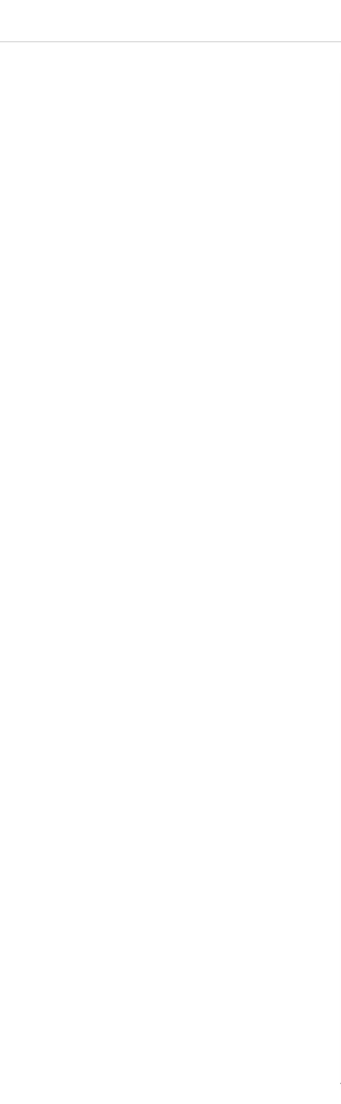
FIGURE 1 T cell counts. The tenth percentile of the normal CD3 + range for age is shown as a dashed line (4). (A) In patient 1, the CD3 + count increased to 3,710 cells/mm 3 ten months prior to implantation, when the patient developed atypical cDGA. Naïve CD4 + T cells appeared at 5.7 months post-CTTI and increased steadily over the next several months. (B) Patient 2 had low, but detectable, naive T cells with 7 naïve CD4 + T cells/mm 3 three months after transplant. The large increase in CD4 + T cells seen at day 105 post CTTI was concerning for development of immune reconstitution in fl ammatory syndrome. (C) In Patient 3, naïve T cells appeared 6.8 months after CTTI, and have persisted for over six years. The large increase in CD8 + cells at month 48 was due to acute Epstein-Barr virus